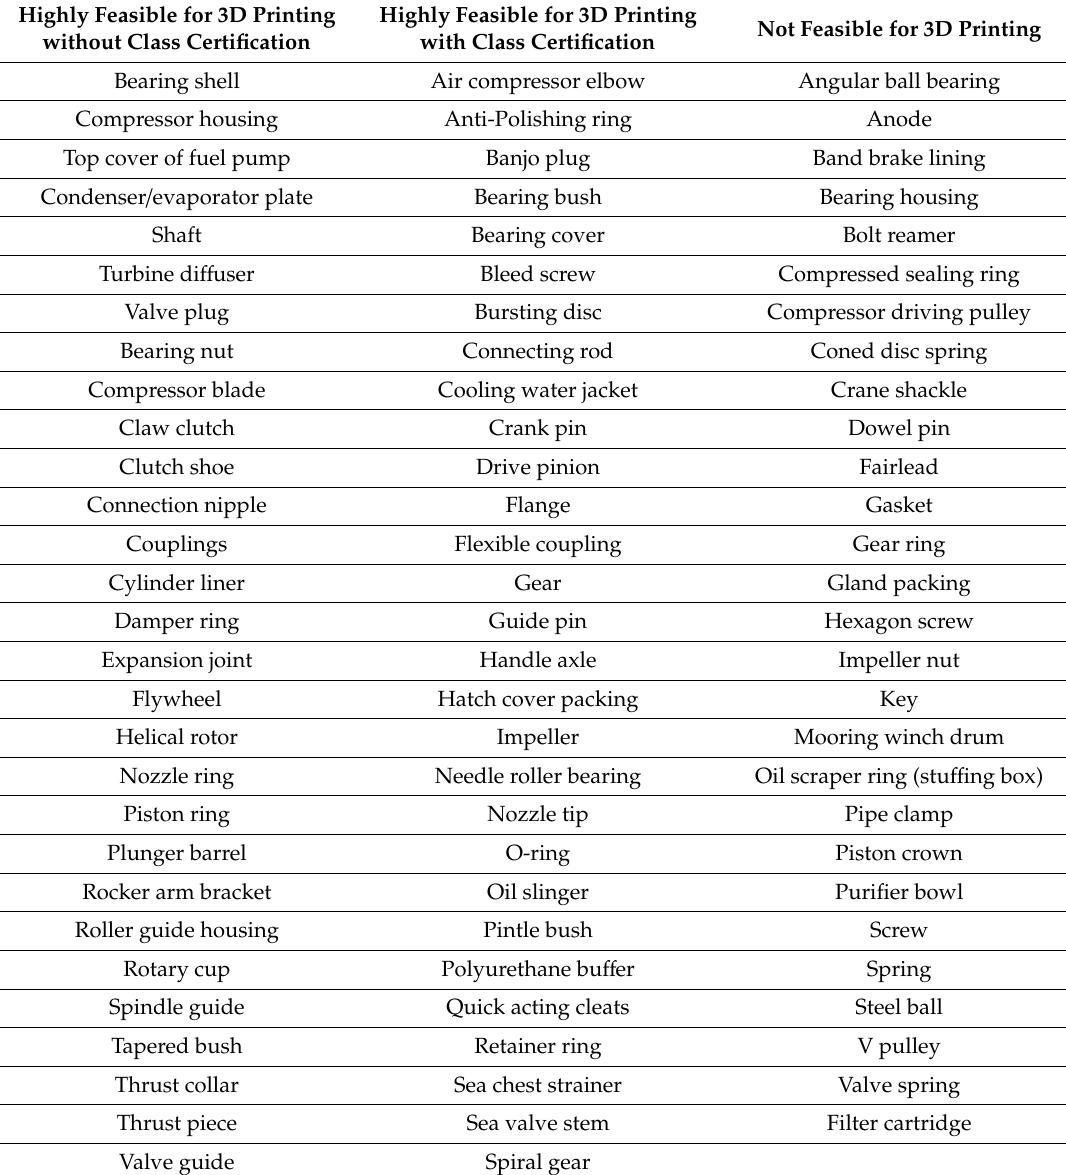
Table 3. Division of parts into incremental methods